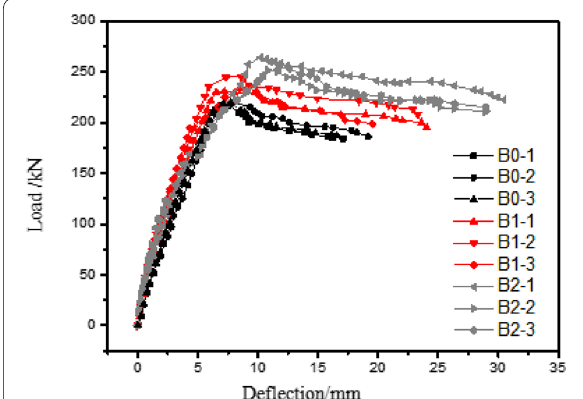
Fig. 6 Load–midspan deflection curve of test